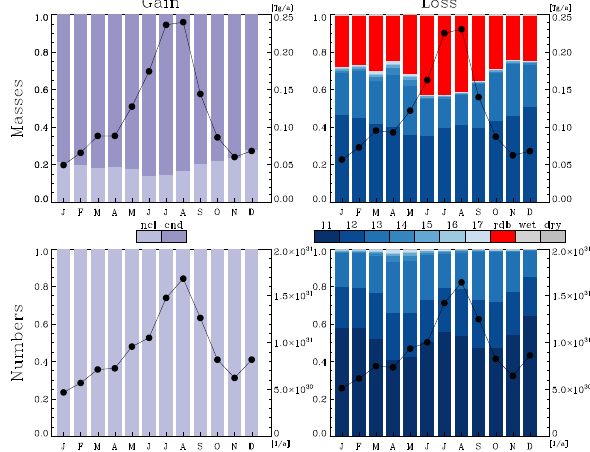
Figure 7. Seasonal cycle of regional tendencies of the nucleation mode over East Asia (see Fig. 1). The colored bars show fractional Fig. 7. Seasonal cycle of regional tendencies of the nucleation mode tendencies (left axis) for the processes defined in Table 2. The solid over East-Asia (see Fig. 1). The coloured bars show fractional ten- line (right axis) shows the total dencies (left axis) for the processes defined in Table 2. The solid line (right axis) shows the total tendency.